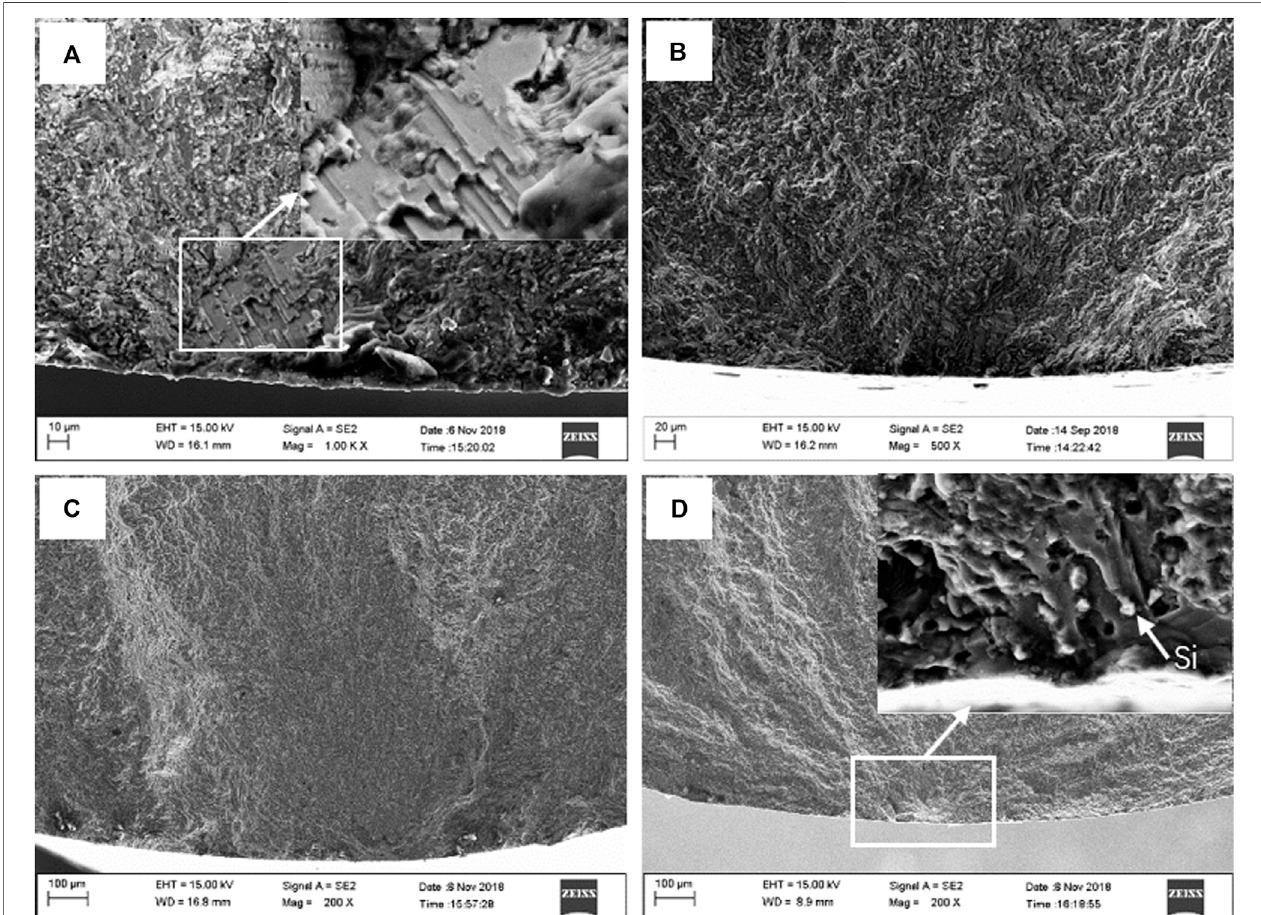
FIGURE 7 | Fatigue crack initiation zone of the alloy in different conditions and stress amplitudes, (A) T1-140 MPa, (B) T1-160 MPa, (C) T4-180 MPa, (D) T6- 180 MPa.